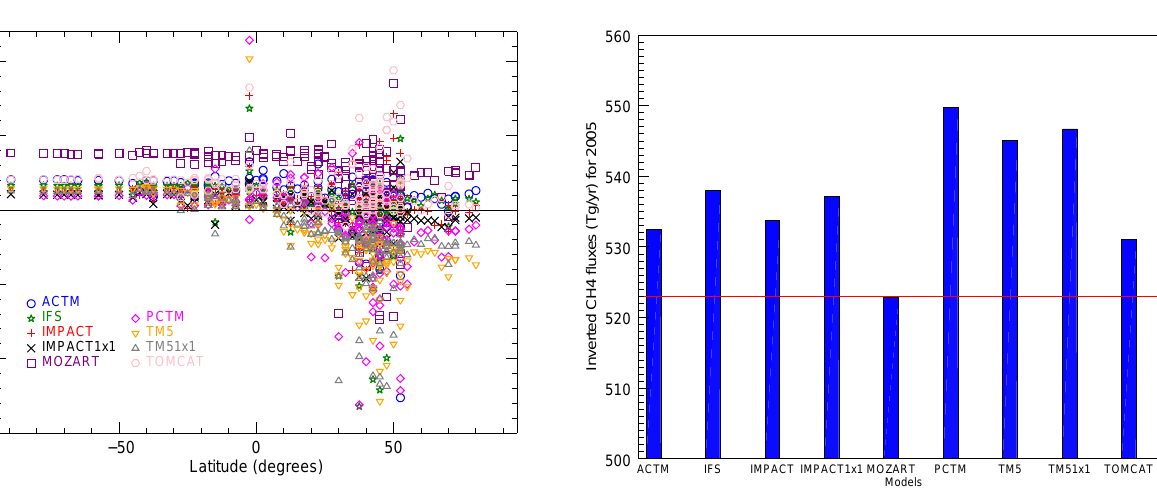
Fig. 7. Latitudinal distribution of the bias between CH 4 mix- Fig. 8. Inverted CH 4 fluxes for every TransCom model at the global ing ratios simulated by LMDZ-SACS and TransCom mod- scale in 2005. The red line represents the value of the target methane els ( y LMDZ − y ( TransCom model ) ) at all surface stations. Each flux at the global scale (523Tg in 2005 – INV i TransCom model is represented by a specific symbol. The bias is expressed in ppb.